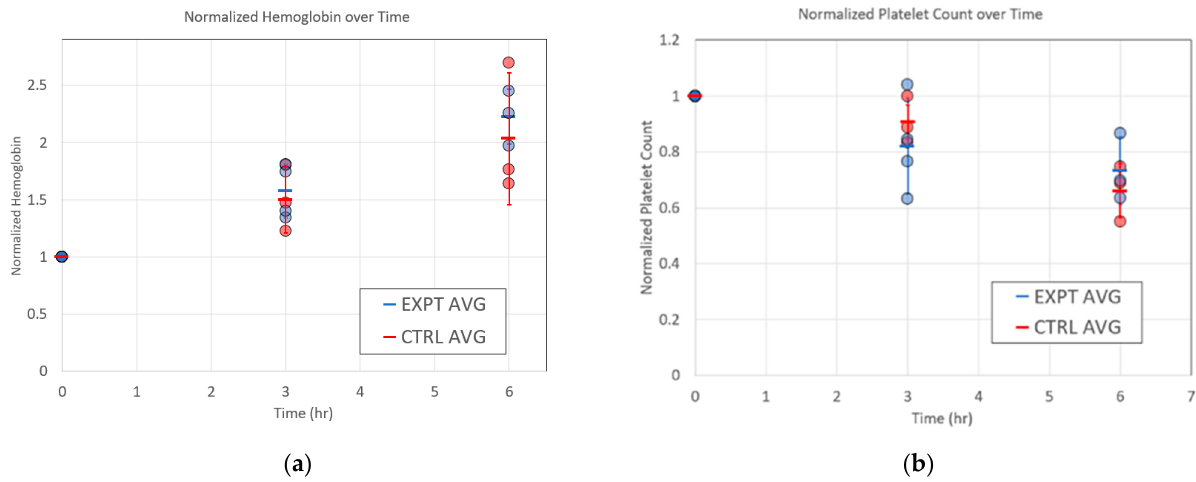
Figure 7. ( a ) Measurement of normalized plasma-free hemoglobin for the RAD2v2 microfluidic oxygenators (blue, n = 5) and control circuits (red, n = 3), showing standard deviations. ( b ) Normalized platelet count for microfluidic oxygenators (blue) versus control circuits (red). Three microfluidic devices completed the 6 h study, while two devices were terminated after 1.5 h and 3.5 h due to circuit